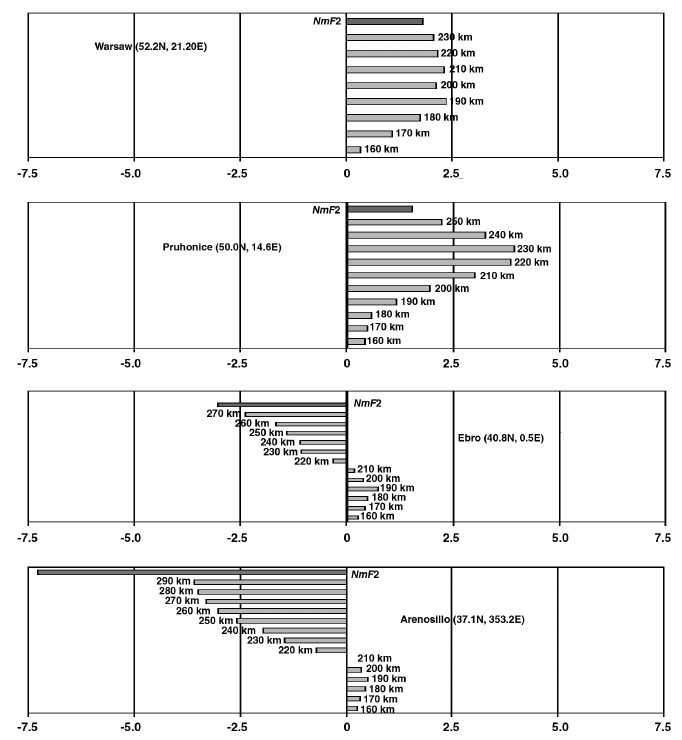
Fig. 12.5. The magnitude of the electron density decrease at F -region heights (the difference between pre-storm quiet days and the storm main phase at 11:00-13:00 UT) for the geomagnetic storm of February 1998.